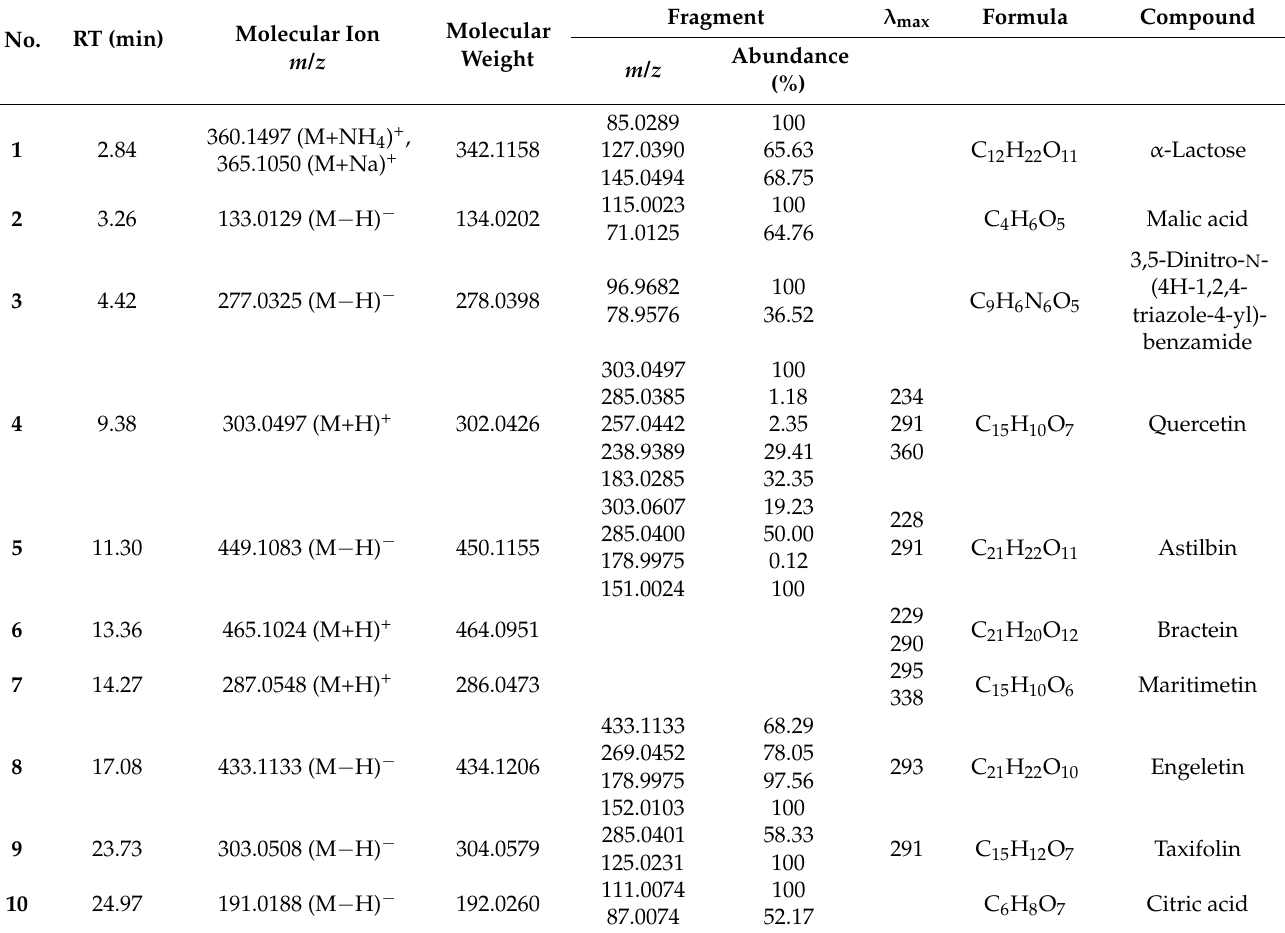
Table 1. Composition identifications by